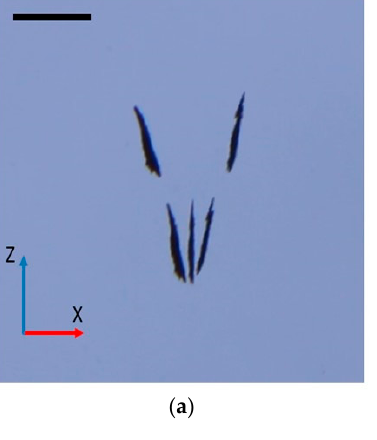
Figure 11. Demonstration of rotation control in the O-XZ plane: ( a ) Time-lapse image sequences show a nanocarrier cluster in the O-XZ plane (viewed from front) rotated along the X -axis then keeping the orientation and moving forward (scale bar is 1 mm); ( b ) Counterclockwise and clockwise angles along the X ‐ axis for 10 and 50 V between two sides of the tweezers.